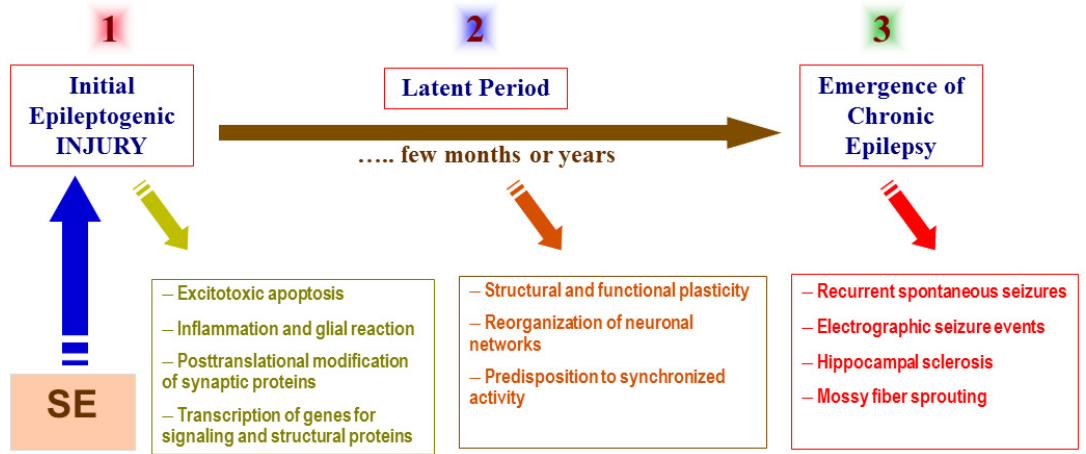
Figure 1. The pathophysiological basis of epileptogenesis following SE episode. The mechanisms involved in epileptogenesis involve an interaction of acute and delayed anatomic, molecular, and physiological events that are both complex and multifaceted. SE-induced neuronal injury activates diverse signaling events, such as inflammation, oxidation, apoptosis, neurogenesis and synaptic plasticity, which eventually leads to structural and functional changes in neurons. It is a progressive process that produces rearrangement of synaptic circuitry, neurogenesis, mossy fiber sprouting and a hyperexcitability state over weeks or months or years (latent period). These changes are eventually manifested as spontaneous recurrent seizures (epilepsy) in susceptible persons.